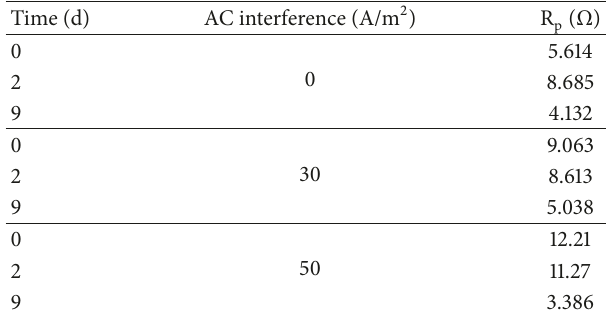
Table 4: Polarization resistance values under different AC interfer-